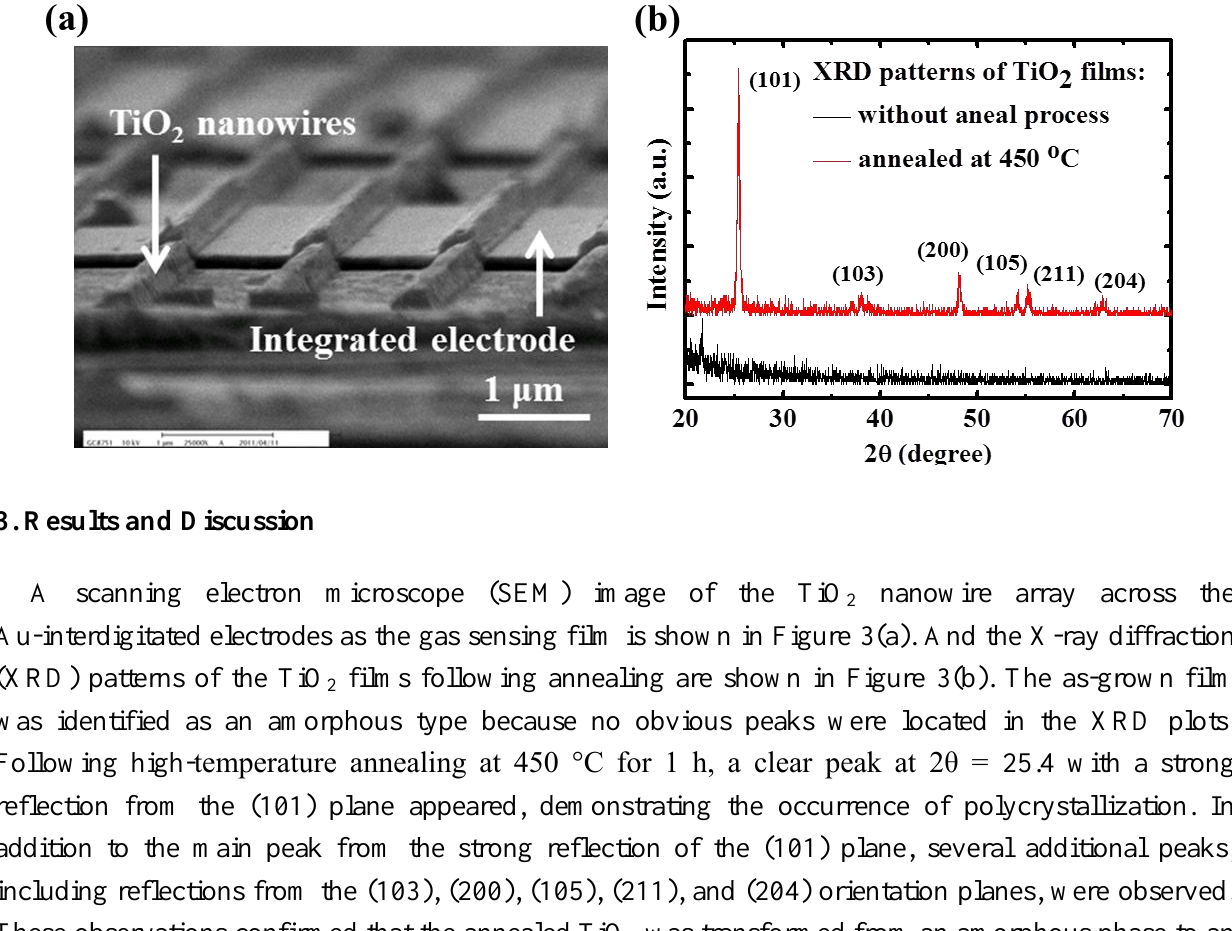
nanowire gas sensor ( b ) XRD patterns of TiO 2